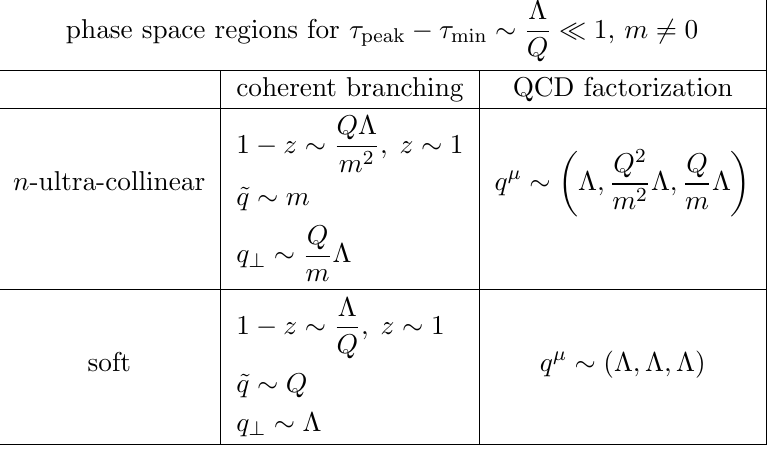
Table 2. Power counting for coherent branching and QCD factorization for massive